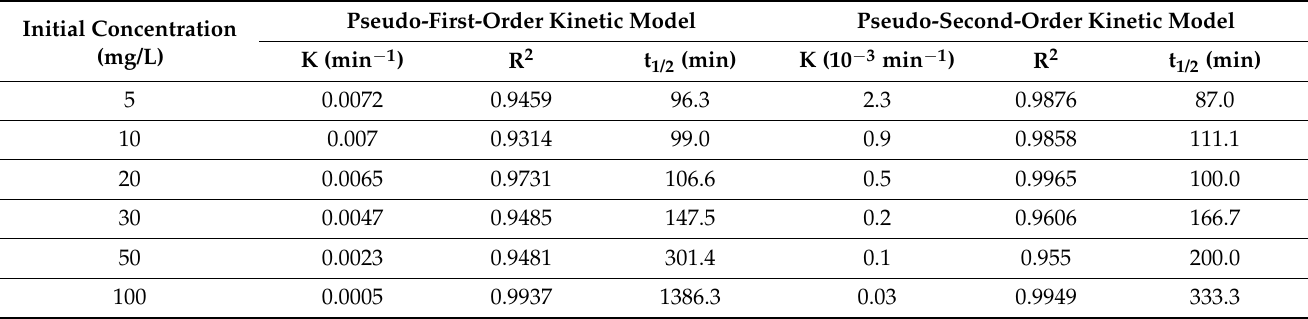
Table 2. TC degradation kinetics parameters with different TC initial concentrations.